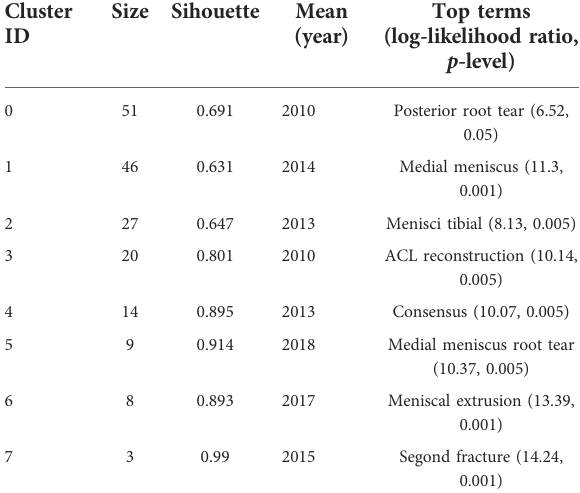
TABLE 9 The signi fi cant co-occurrence clusters of keywords in publications on tear of the root of the meniscus. Cluster Size ID